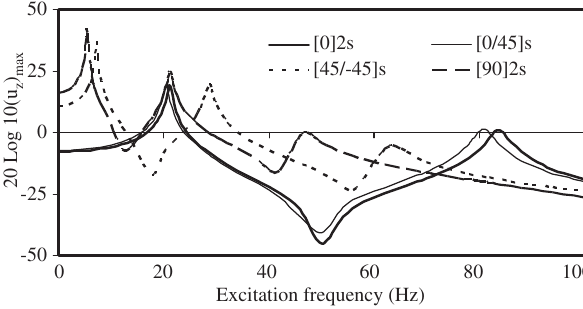
Figure 5 Frequency responses of the pinned-pinned composite beams calculated for the point x = 0.25 L when the harmonic excita- = 0.25 L , ζ = 0.02. tion is applied at x F